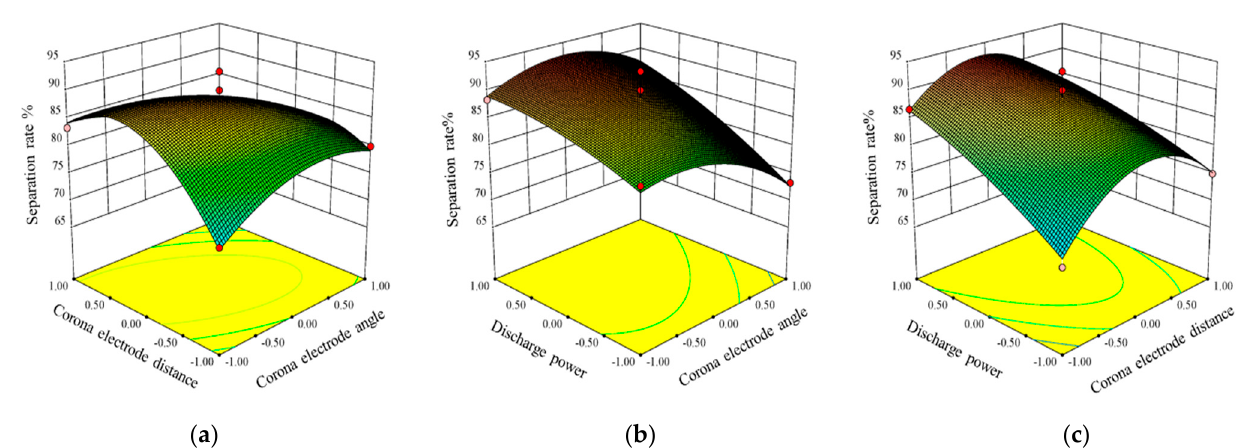
Figure 8. Response surfaces showing the effects of each factor on the separation rate. ( a ) C = 4.5 w, ( b ) B = 172.5 mm, ( c ) A = 25°. ( b ) B = 172.5 mm, ( c ) A = 25 ◦